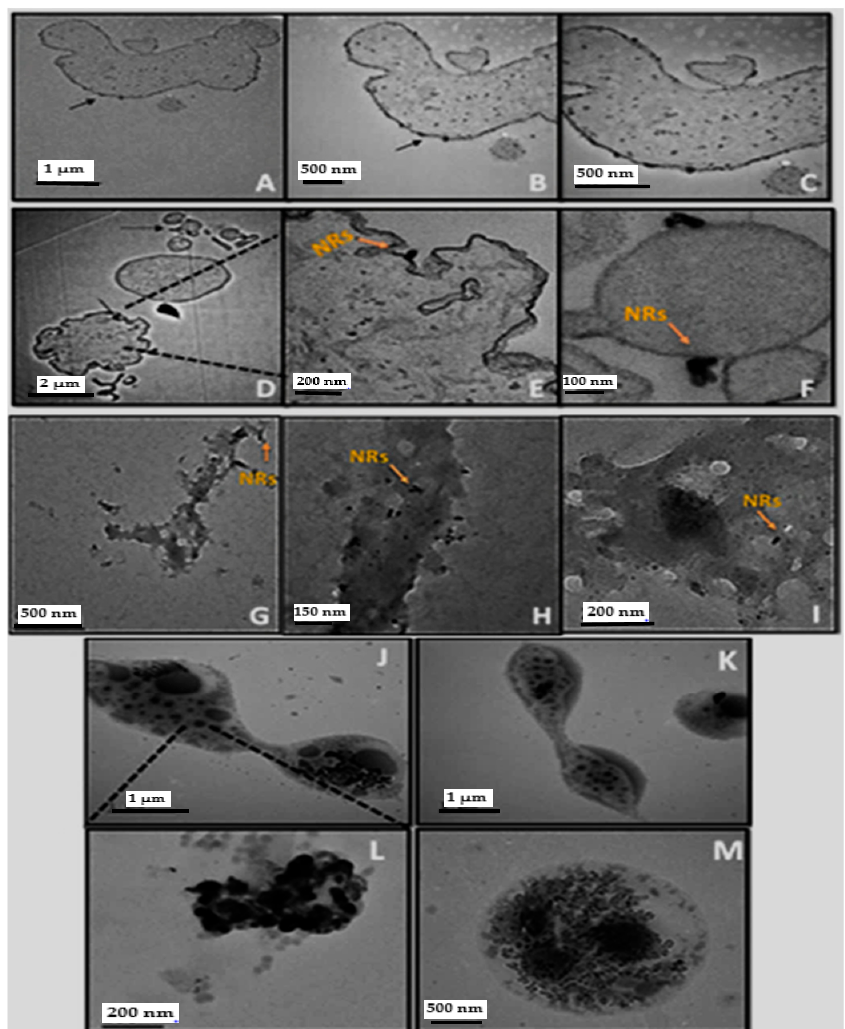
Figure 15. TEM images of U87 cells’ sections. The pictures represent: ( A – F ) Cells treated 1 h after the addition of BPEI-coated IONRs at a concentration of 5 µ g/mL, and show the rods on the border of the cell membrane. ( G – I ) Cells after 4 h of being incubated with BPEI-coated IONRs at a concentration of 5 µ g/mL for 4 h. The IONRs that are under 100 nm start to enter the cells and localise in the cytoplasm. All mitochondria are free from IONR. ( J , K ) Cell division 4 h after the addition of carnosine (25 mM). The mitochondria are loaded with carnosine. ( L ) The mitochondria following treatment with carnosine. ( M ) The cell reacting by changing its morphology into spheres.